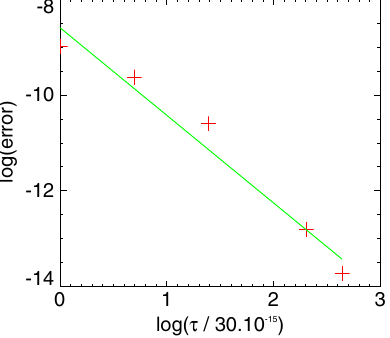
FIG. 13. The magnitude of the residual factor (discussed above and in Fig. 12), which is seen in convergence studies of a laser pulse launched from the simulation boundary, is shown here to decrease quadratically with the length of the laser pulse envelope, characterized by the pulse length τ here given in seconds (for fixed shape and fixed laser wavelength).